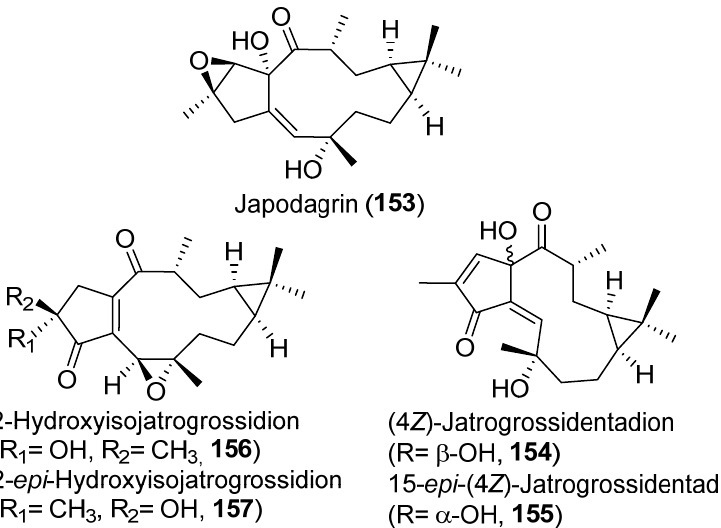
Figure 28. Structure of diterpenes isolated from the root of J. podagrica Hook.